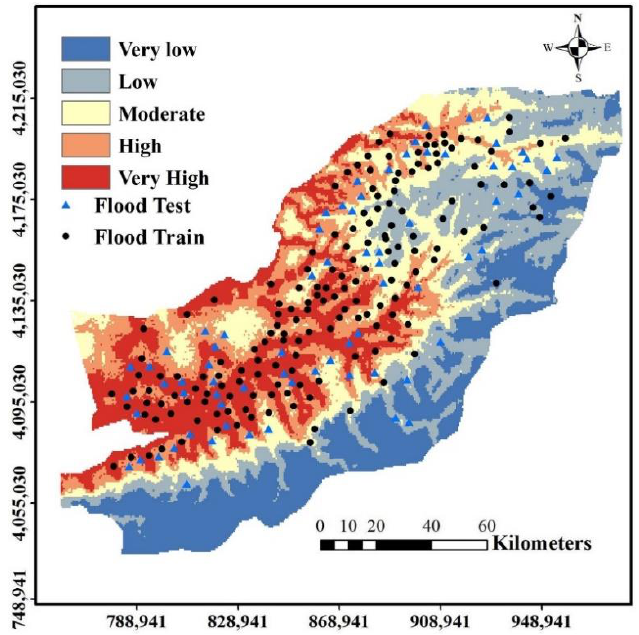
Figure 5. Flood zonation map of the study location (EDAS-WOE-AHP model).